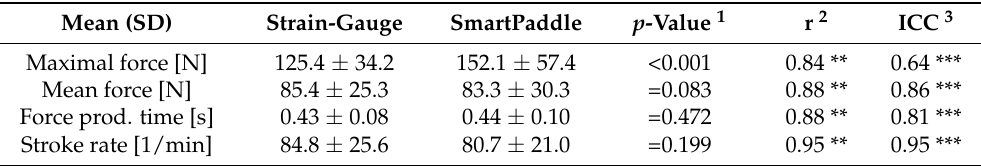
Table 2. Comparison between the strain-gauge paddle shaft and the SmartPaddle (9-axis IMU+ pressure sensor) in key paddle stroke variables ( n =